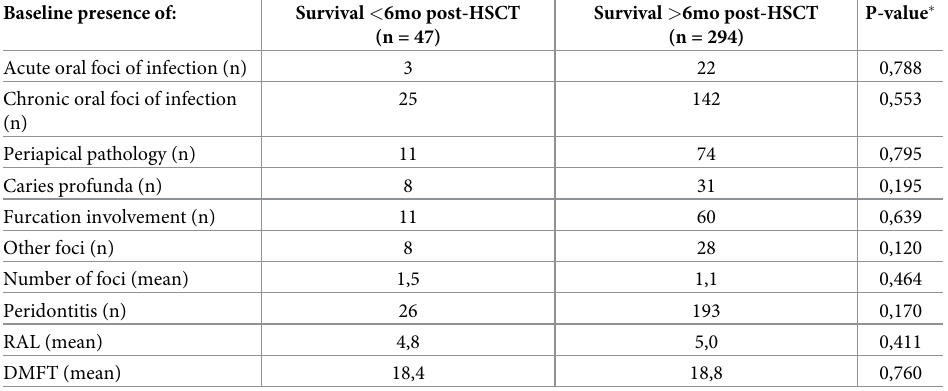
Table 2. Allogeneic HSCT recipients with the presence of oral foci of infection and oral diseases according to six months